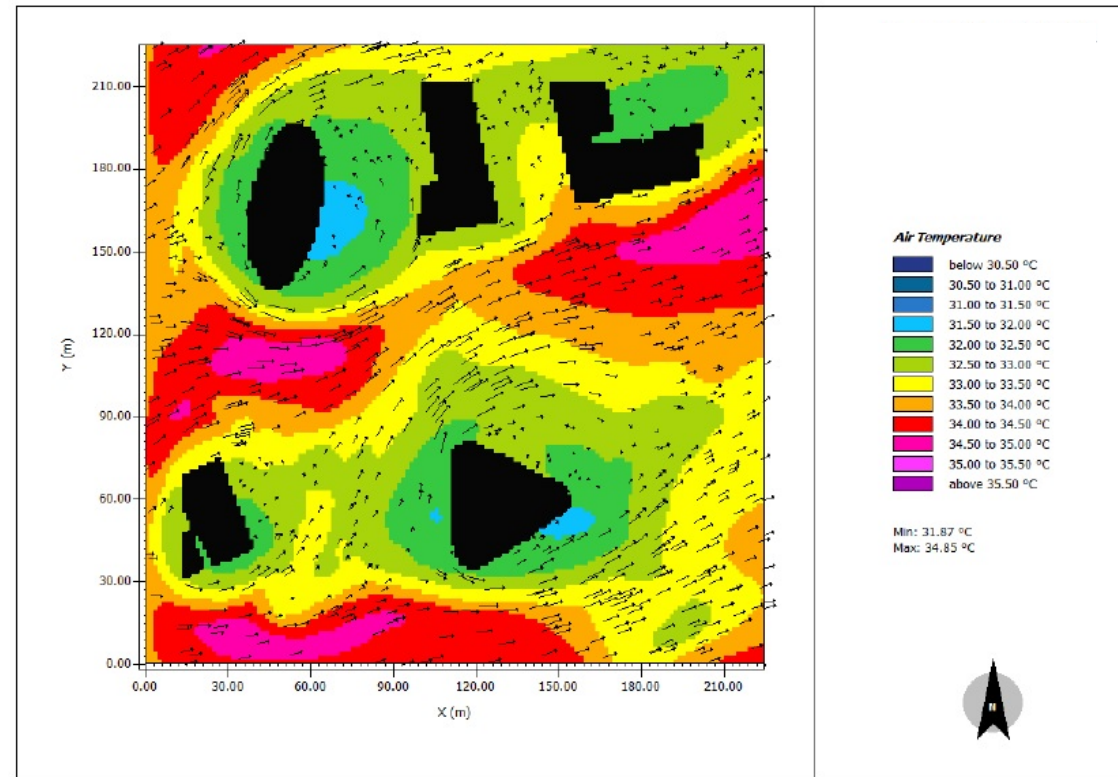
Figure 2. The air temperature distribution under unmitigated conditions for OT7 at 14:00.